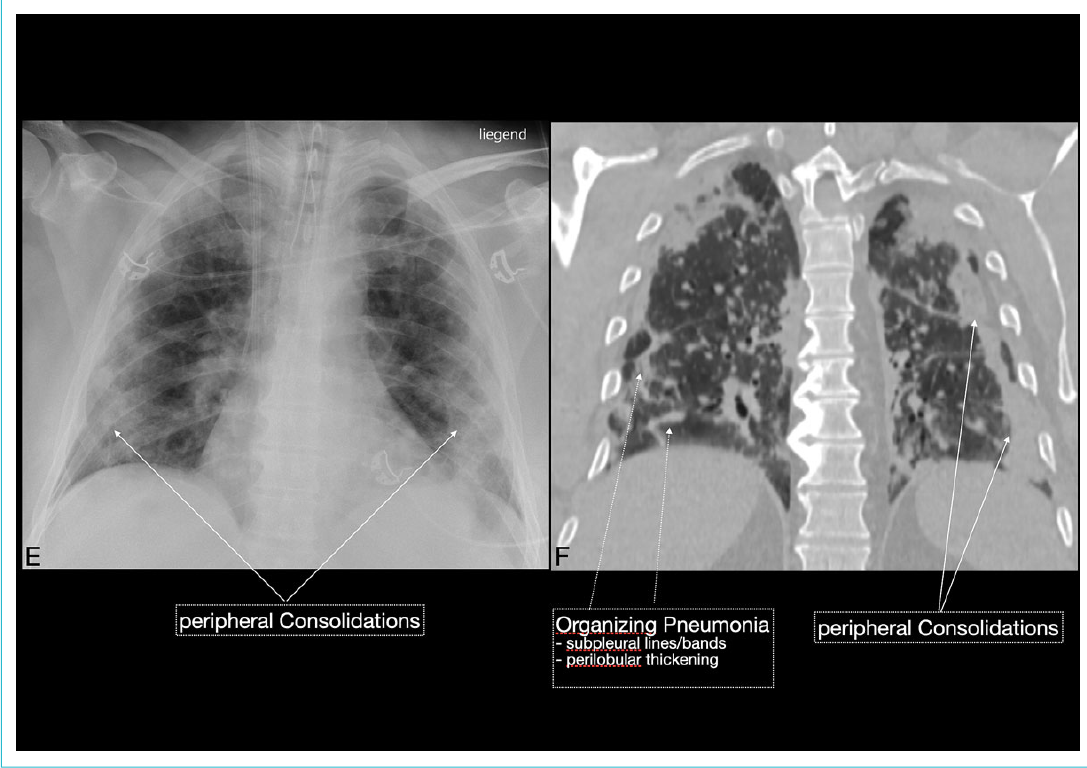
Figure 3 EF: Over time the clinical condition worsened, chest x-ray (E) demonstrated persisting, but mildly improving peripheral consolida- tions, and chest CT (F) demonstrated features of reparative organising pneumonia. The patient’s condition deteriorated and he died from sep- tic and cardiogenic shock 12 days after